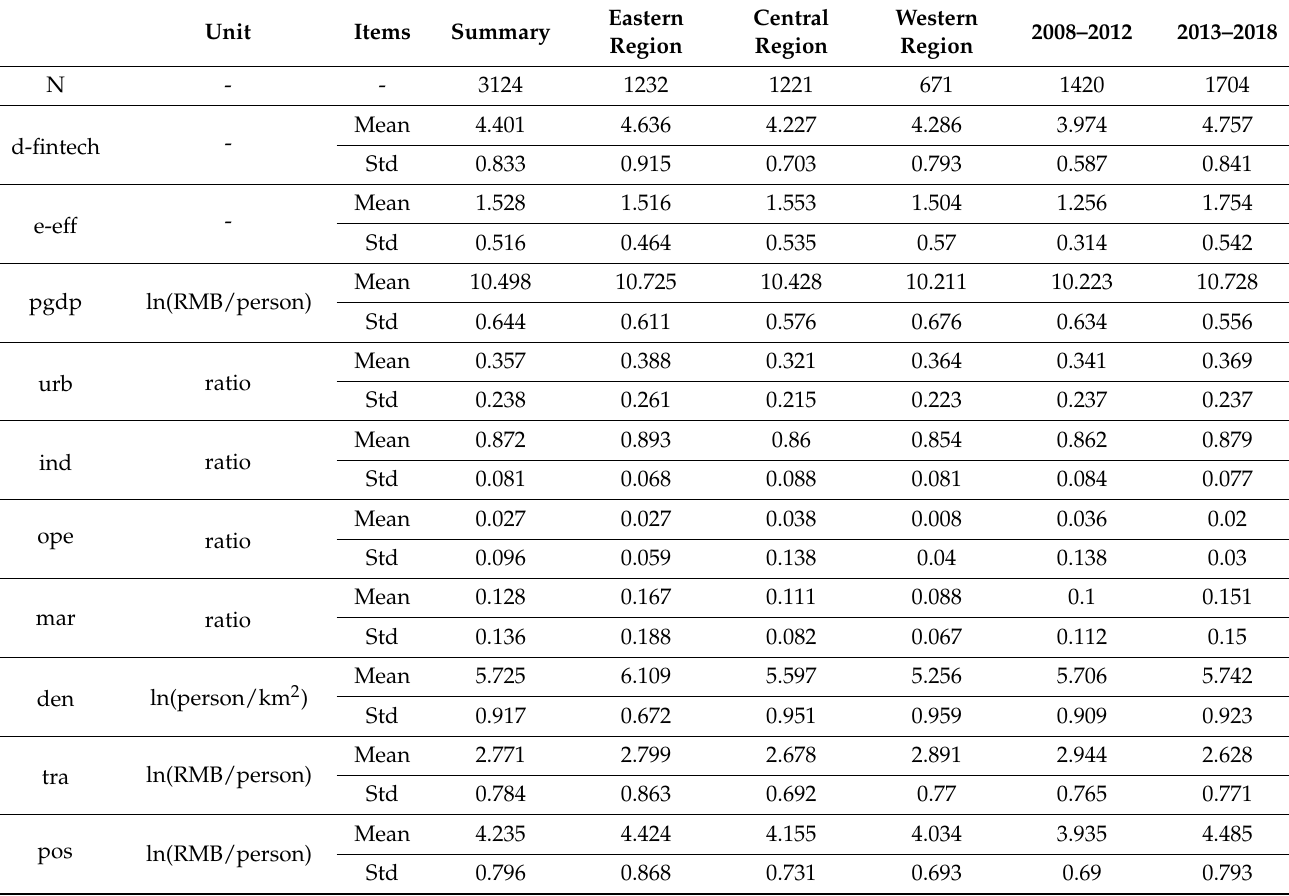
Table 2. Descriptive